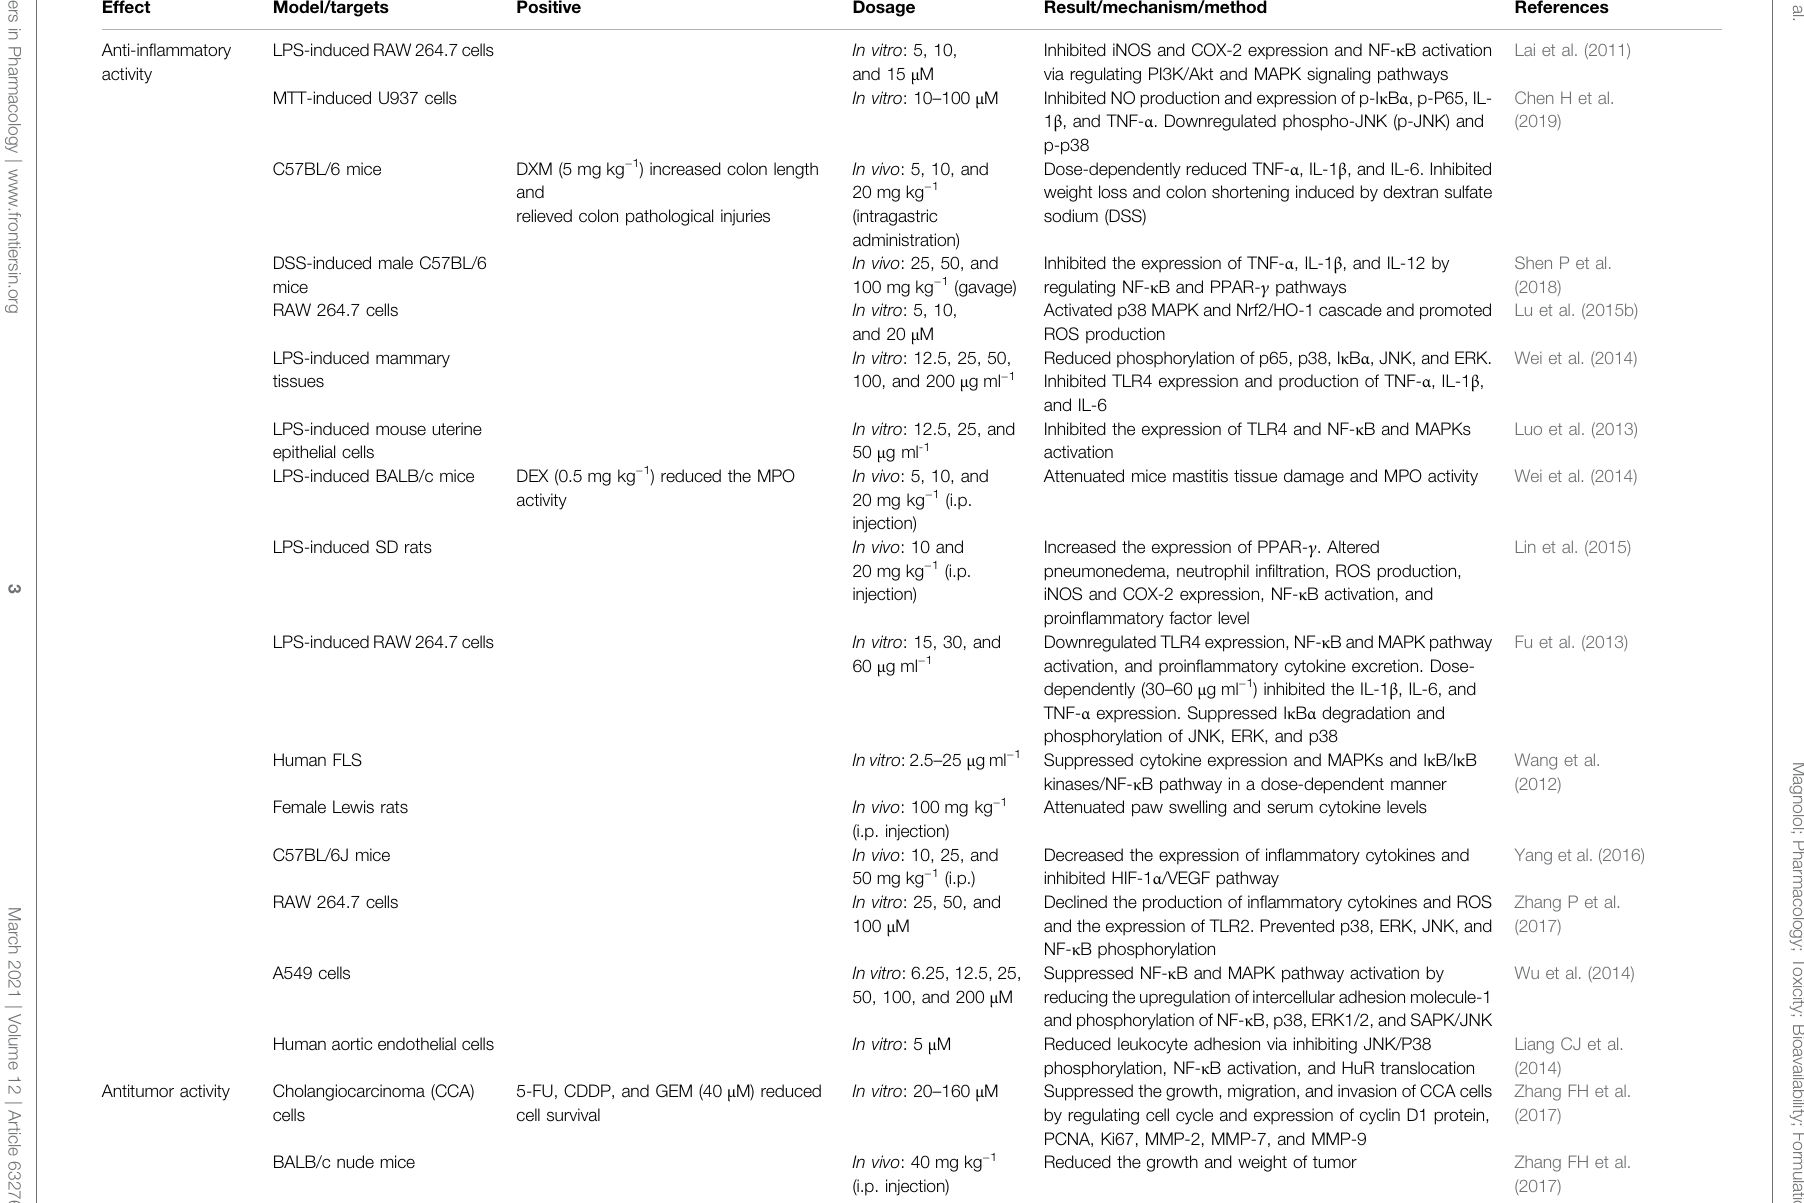
TABLE 1 | Modern pharmacological studies of